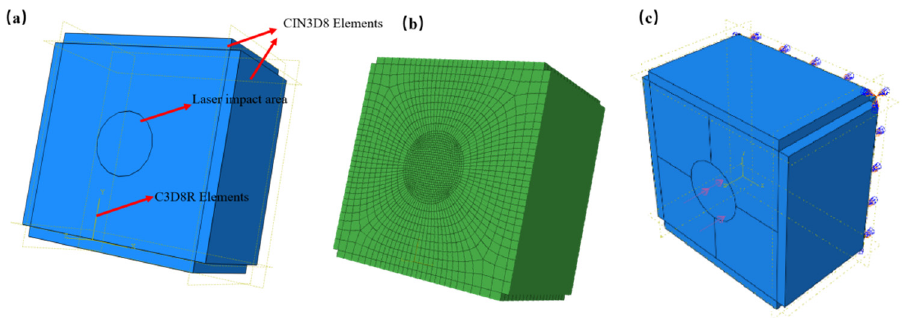
Figure 3. Schematic diagram of the model. ( a ) Partition of model, ( b ) grid distribution, and ( c ) con- straints of model.